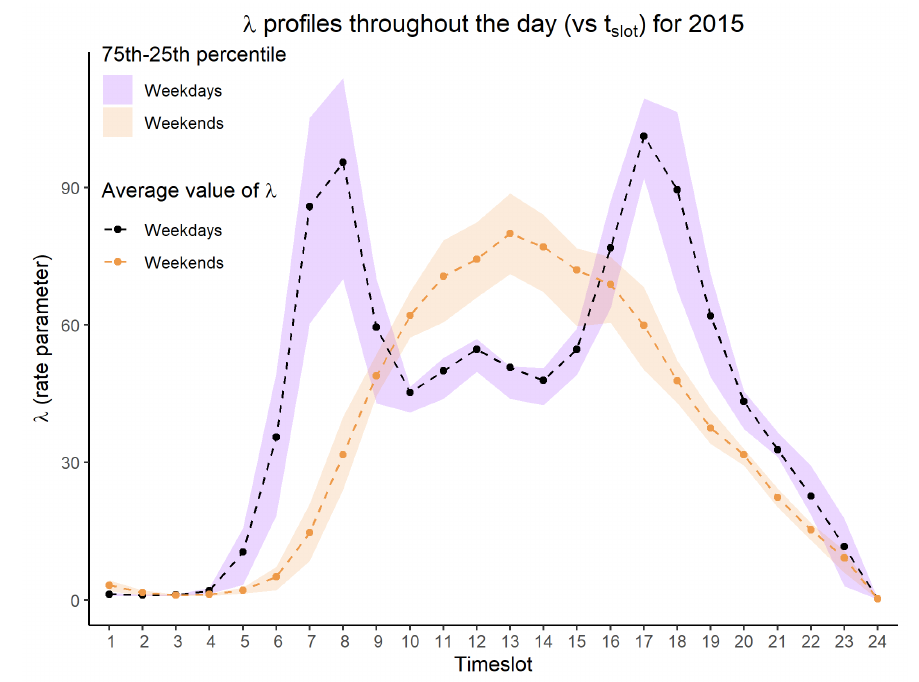
Figure 5. Daily λ profiles for 2015: For each ( m , d t ) combination, we calculated the average arrival rate λ . The dotted line represents the average over those 12 months; the shaded areas indicate the percentile